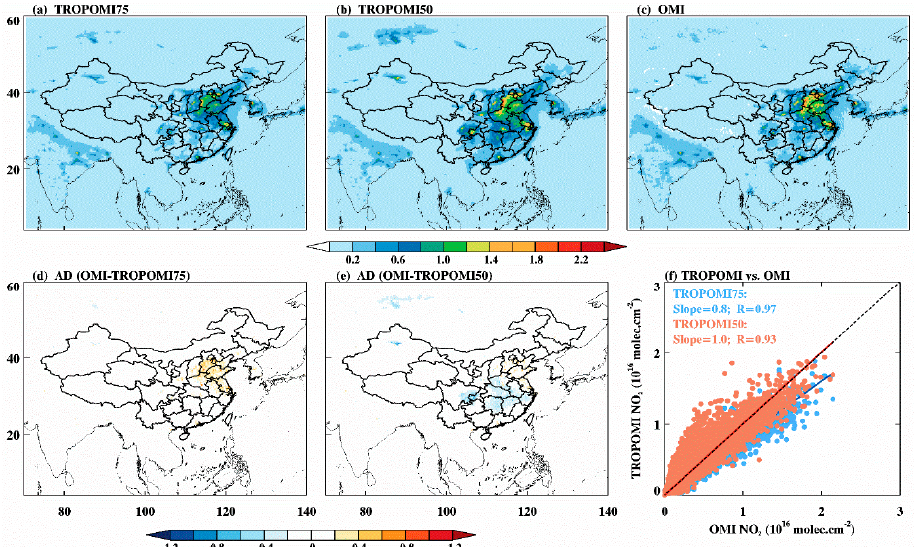
Figure 4. Tropospheric NO 2 distributions averaged over a period from February 2018 to January 2019 (units: 10 16 molec cm − 2 ) ( a ) from TROPOMI75, ( b ) from TROPOMI50 and ( c ) from OMI, along with ( d–e ) absolute difference maps (OMI minus TROPOMI). ( f ) Scatterplot of TROPOMI versus OMI annual mean tropospheric NO 2 columns with regression line superimposed. The slope and correlation coefficient (R) are also shown in the plot.